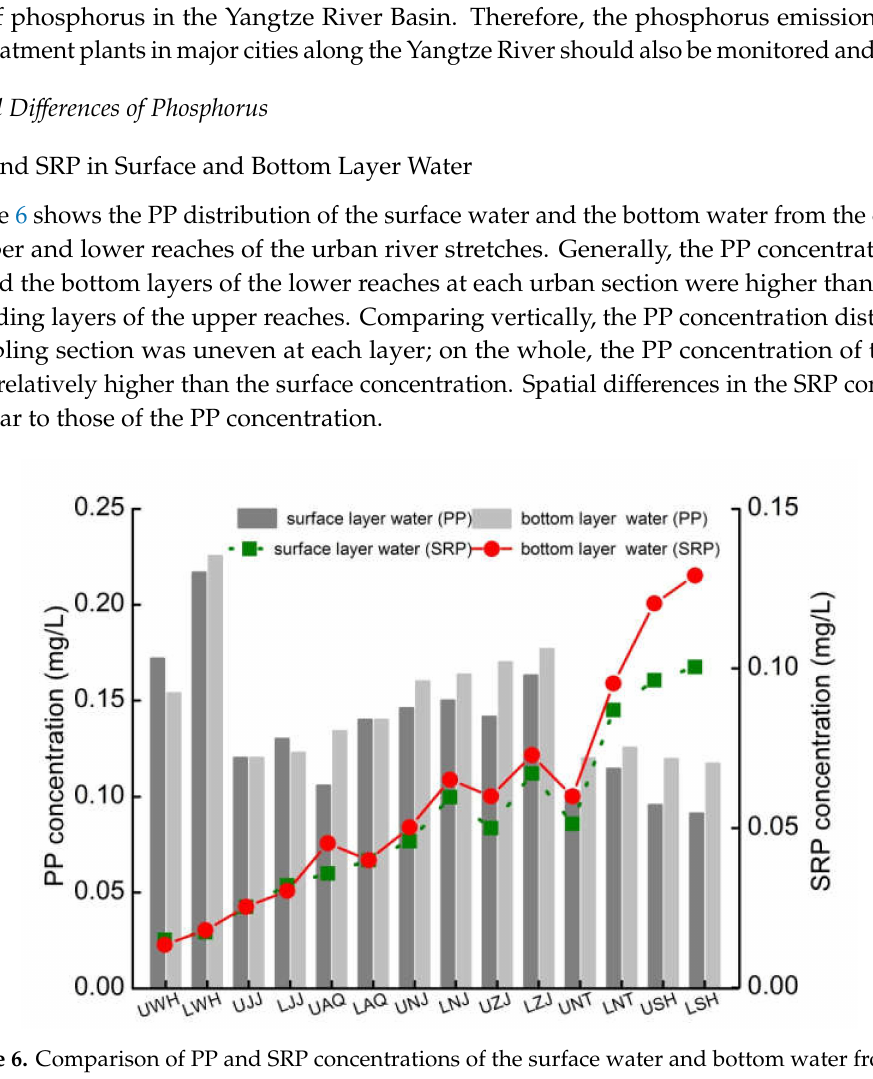
Figure 6. Comparison of PP and SRP concentrations of the surface water and bottom water from the central line in the upper and lower reaches of the urban river